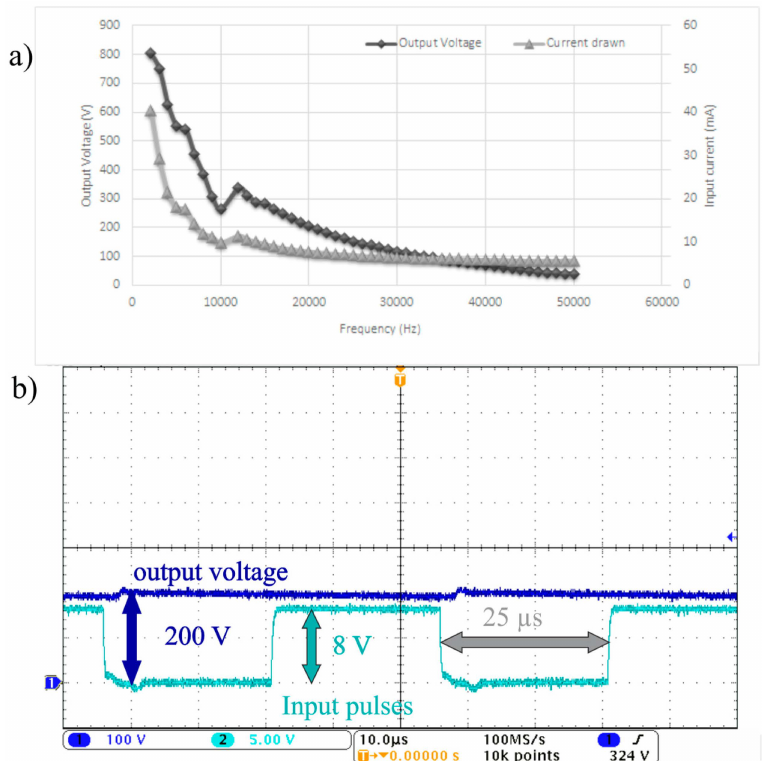
( a ) The output voltage generated experimentally from the DC to DC boost converter and the current drawn versus the frequency when the duty cycle is 50%; ( b ) The output voltage waveform (Dark Blue) and the switching pulses waveform (Cyan) when the duty cycle is 50% and the frequency is 20 kHz where the vertical scale where the vertical scale for the output voltage waveform and the switching pulse waveform is 100 and 5 V,